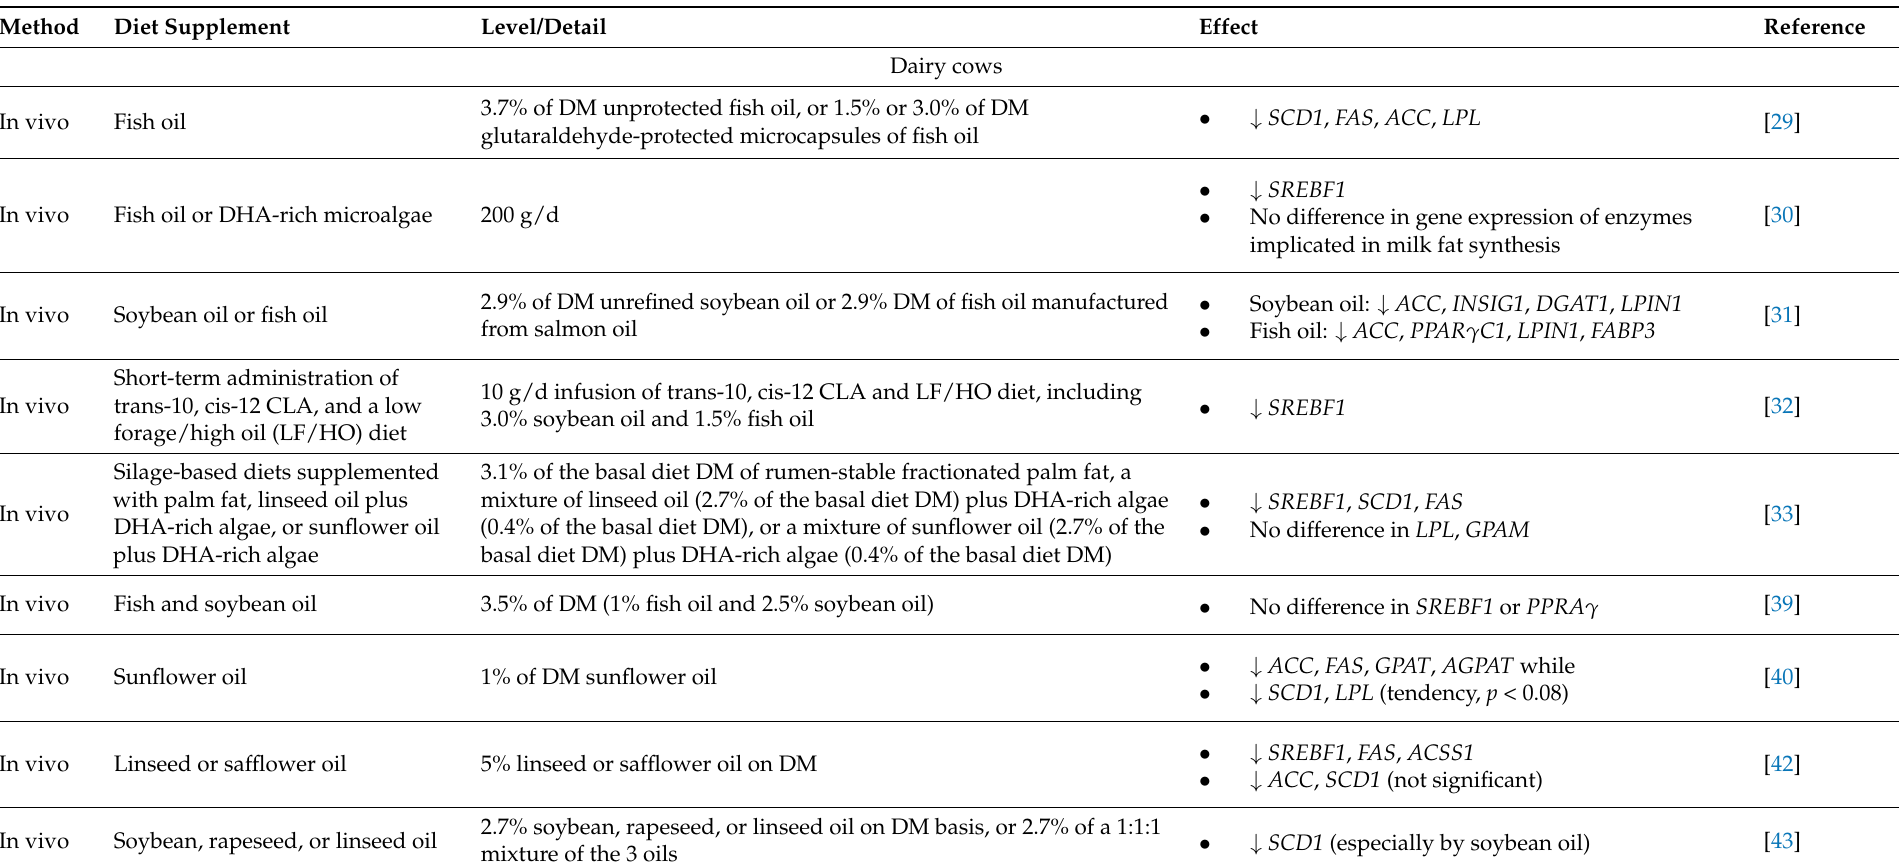
Table 2. Selected studies presenting the impact of PUFA-rich diets and supplements on mammary gland gene network that regulate fat